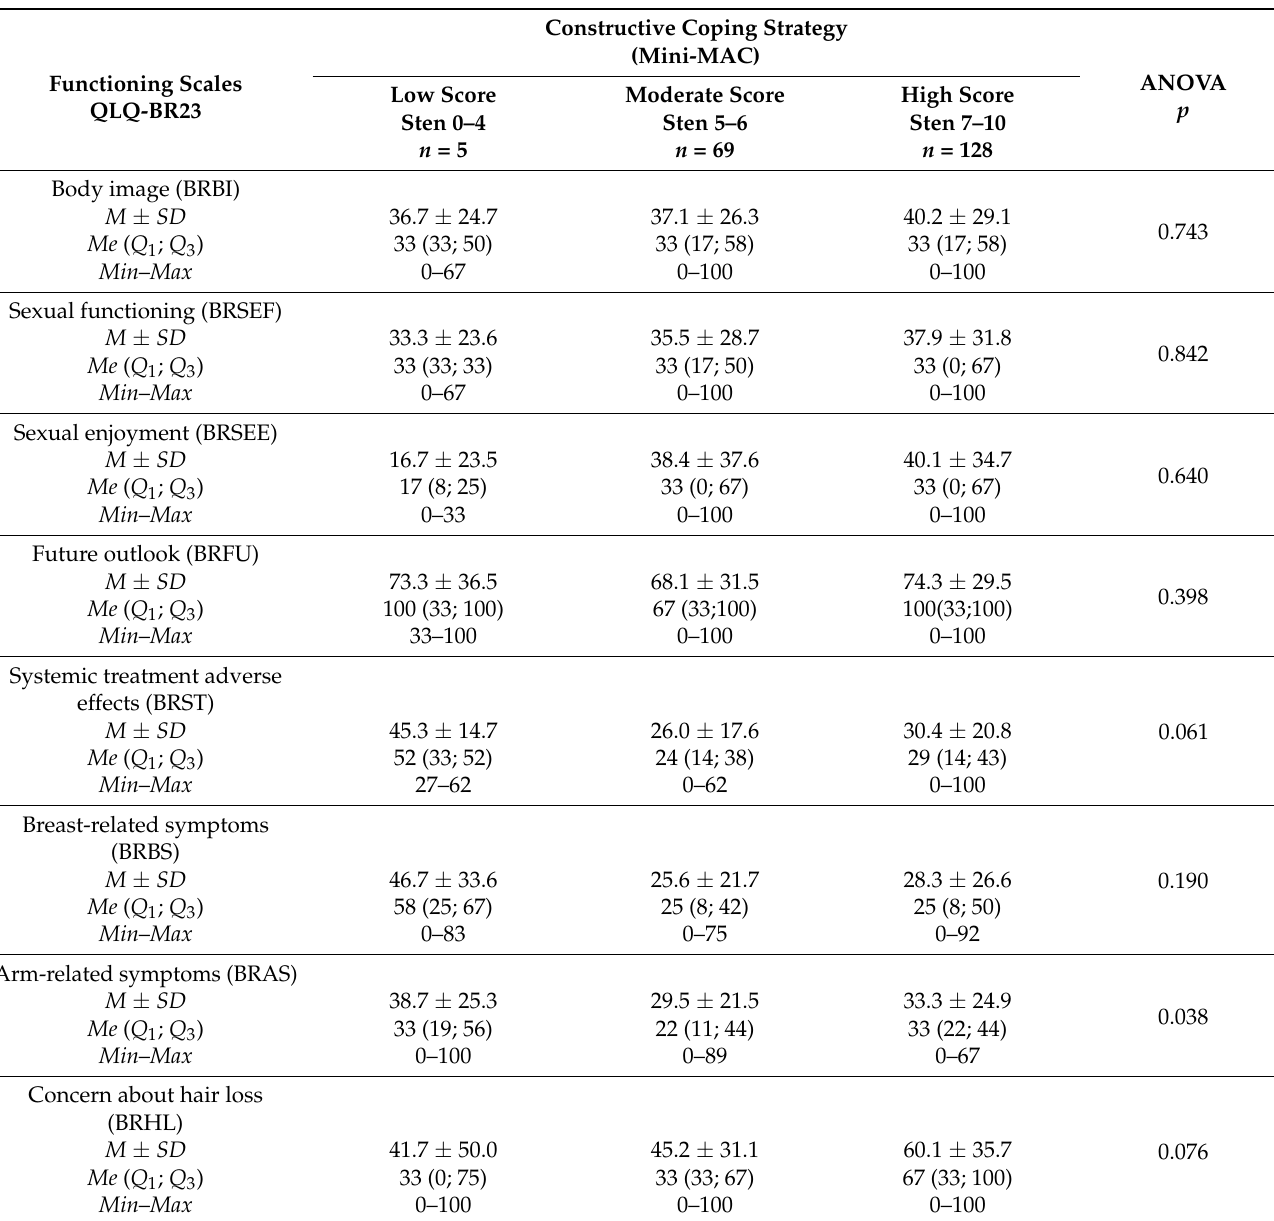
Table 6. Quality of life (EORTC QLQ-BR23 scores) in patients differing in terms of scores for the constructive coping strategy, with analysis of variance